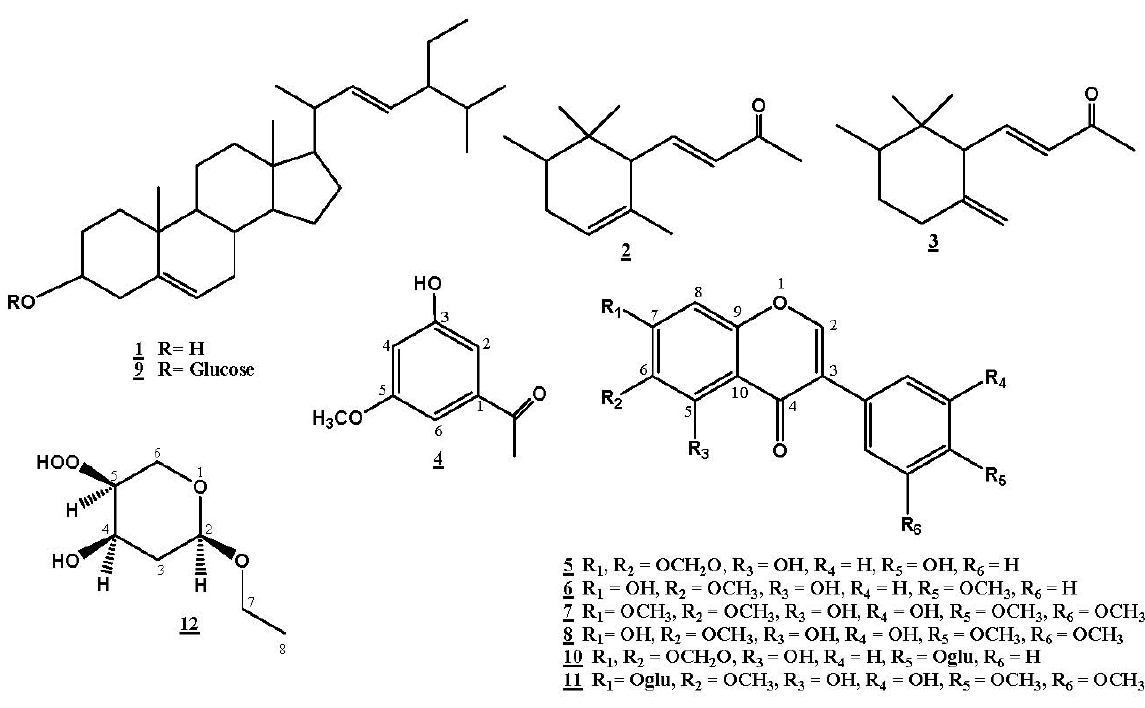
Figure 1. Structures of isolated